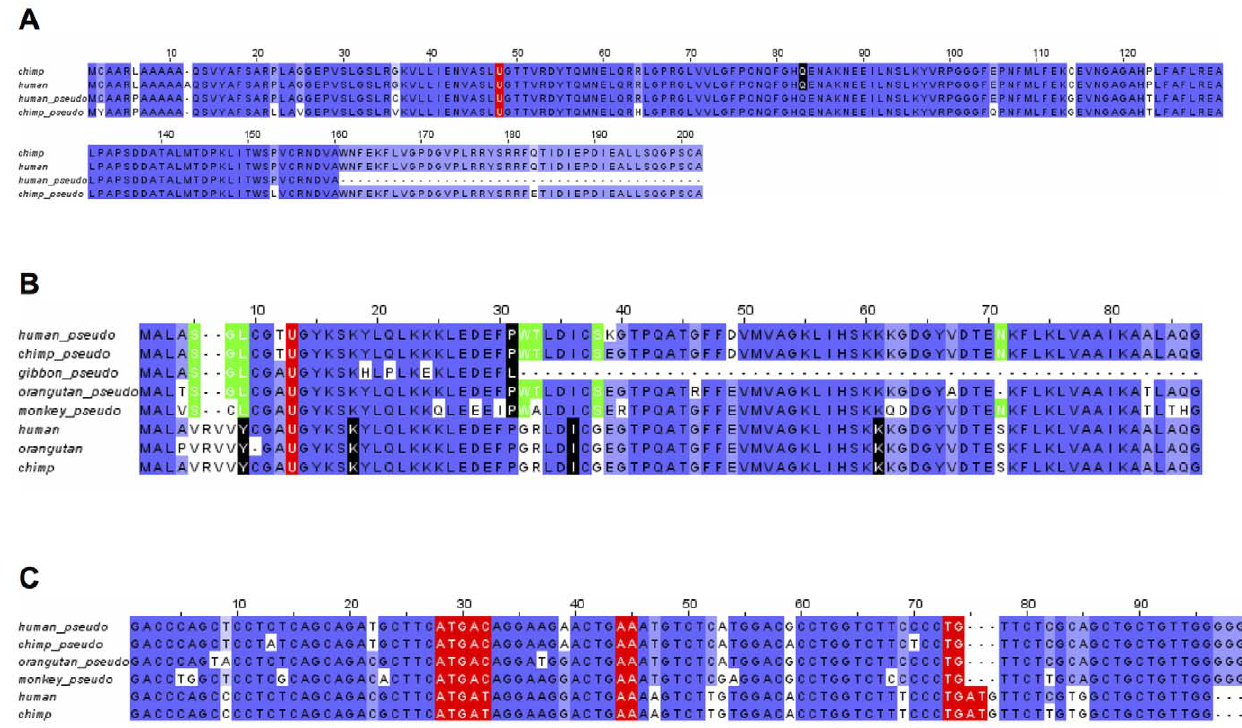
Figure 7. Multiple sequence alignment of selenoprotein genes and pseudogenes. A. GPx1. Multiple sequence alignment of human and chimpanzee GPx1 pseudogenes. B. SelW. The last residue of each exon is marked in black and Sec in red. Residues marked in green are described in the text. C. SECIS elements of SelW and SelW pseudogene. doi:10.1371/journal.pone.0033066.g007 PLoS ONE |